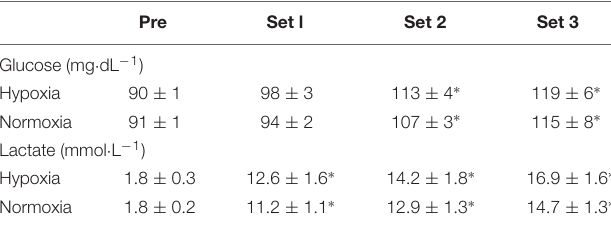
TABLE 2 | Blood glucose and blood lactate concentrations during double-poling sprint